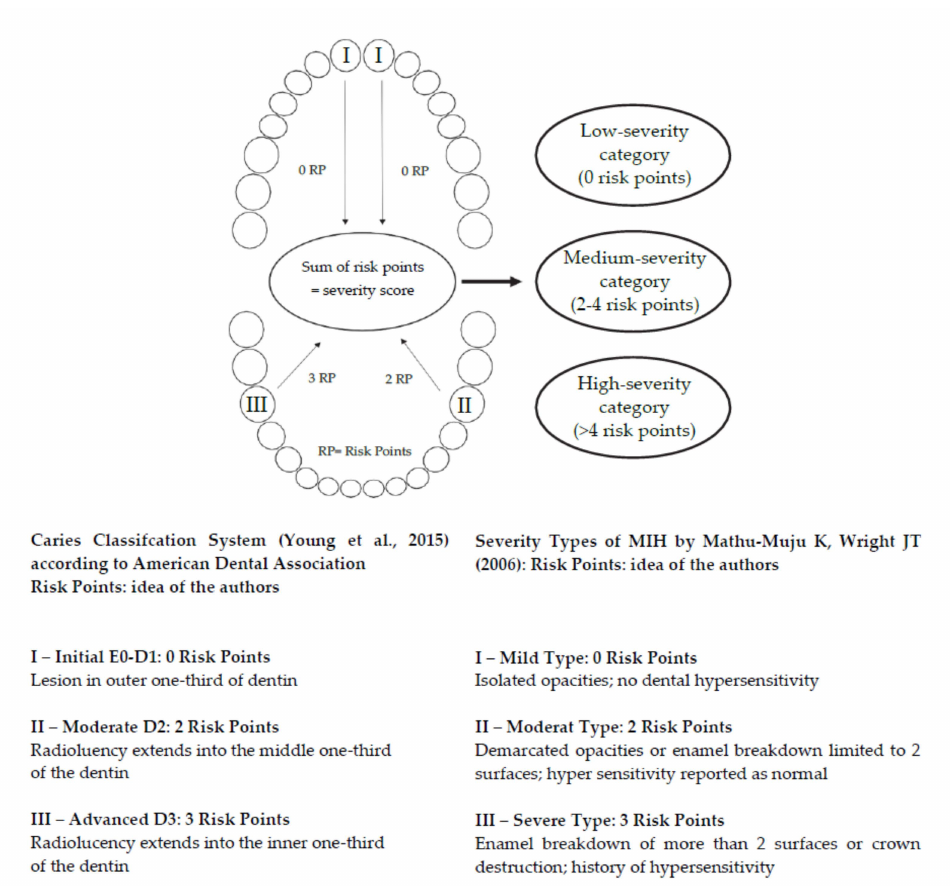
Figure 1. Schematic presentation for detection of the severity score of the patients’ caries-affected or MIH-affected teeth to divide them into severity categories (Michaelis et